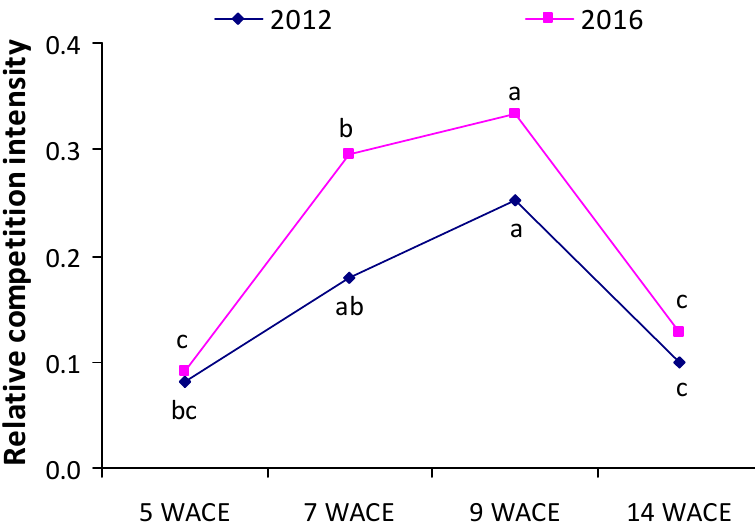
Figure 5. Relative competition intensity (RCI) index at various weeks after crop emergence (WACE) in the first and second growing seasons. Different letters in each growing season indicate statistically significant differences at p < 0.05.